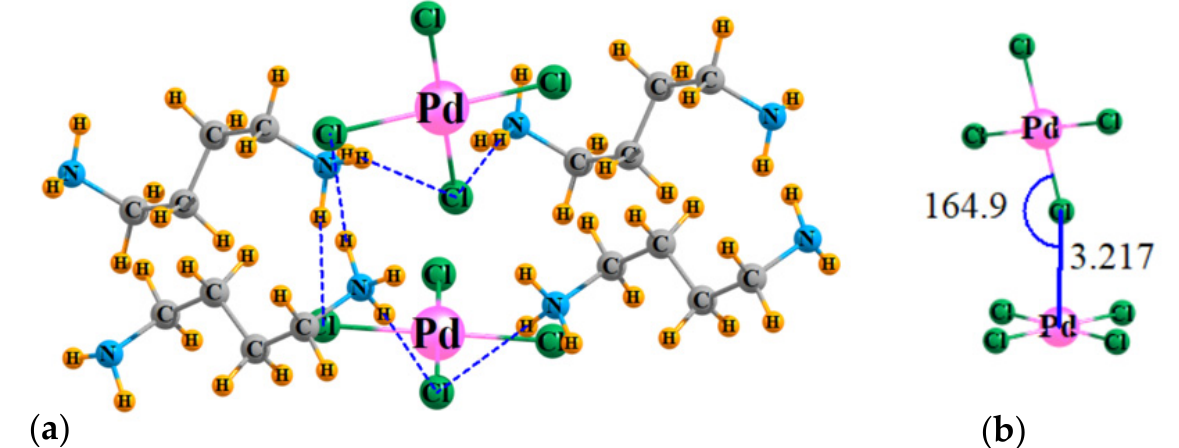
Figure 2. ( a ) Geometry of the PdCl 42 − dimer, surrounded by four counterions, with coordinates taken directly from X-ray structures; H atom positions optimized. ( b ) Detailed structure of [PdCl 42 − ] 2 . Distances in Å, angles in degs.